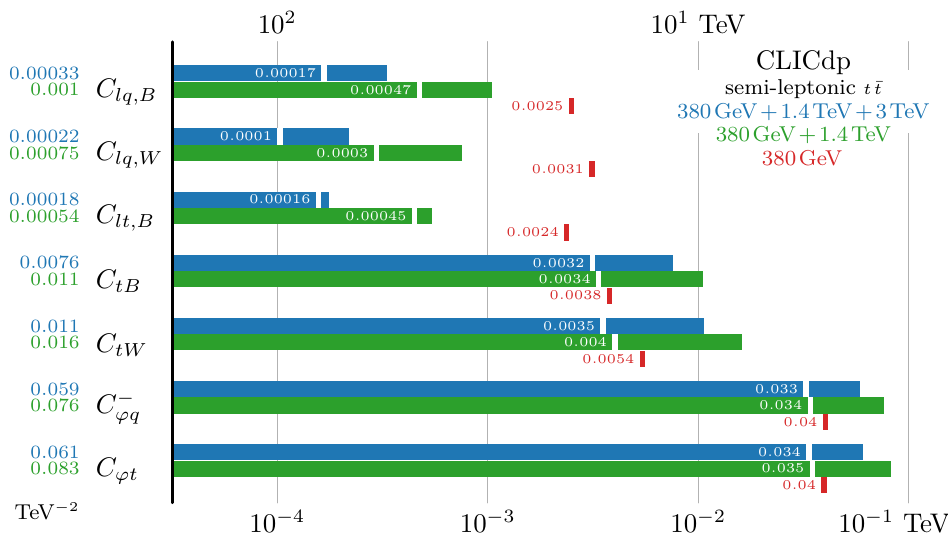
Figure 35. Summary of the global EFT analysis results using statistically optimal observables for the three CLIC energy stages. The colour bars indicate the 1 (cid:27) constraints on each of the seven Wilson coe(cid:14)cients. The blue bars illustrate the results for the full CLIC programme of consecutive operation at 380 GeV, 1 : 4 TeV, and 3 TeV, using respectively 1 : 0 ab (cid:0) 1 , 2 : 5 ab (cid:0) 1 , and 5 : 0 ab (cid:0) 1 , equally shared between (cid:6) 80% electron beam polarisation con(cid:12)gurations at the initial stage and split in the ratio 80:20 at the higher-energy stages. Similarly, the green bars give the results of operation at 380 GeV and 1 : 4 TeV, excluding the 3 TeV stage. The corresponding individual operator sensitivities are shown as ticks. Note that a global (cid:12)t is not possible for operation at 380 GeV alone, for which the individual operator constraints are shown in